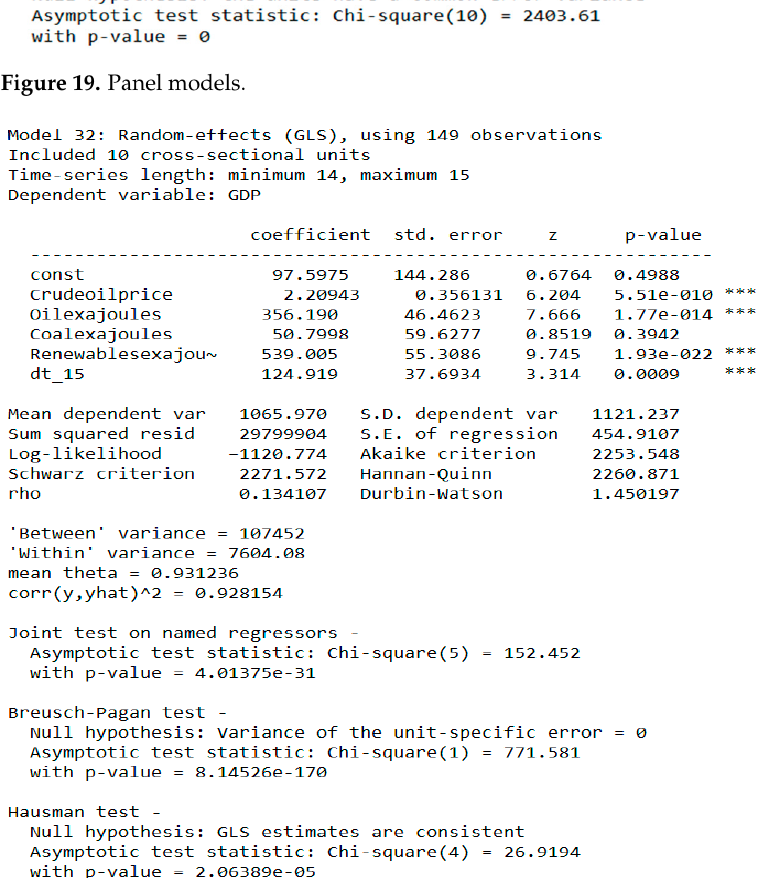
Figure 19. Panel models.